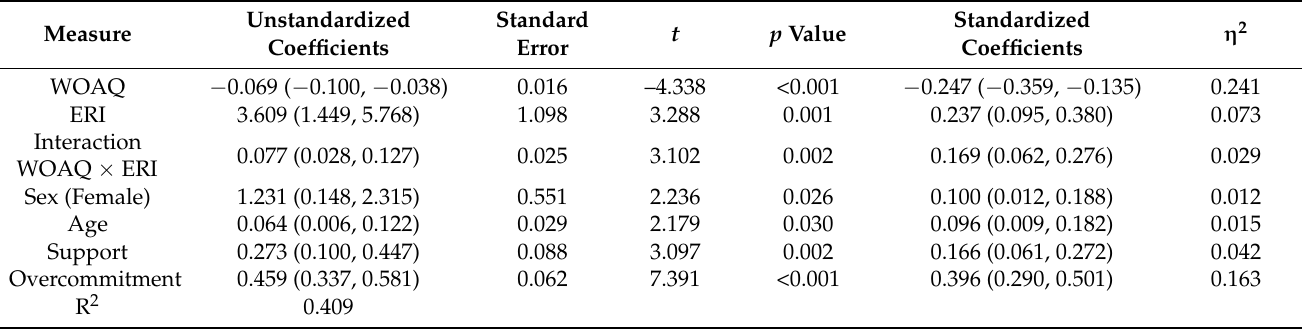
Table 5. Adjusted direct and indirect associations of work organization with psychological health